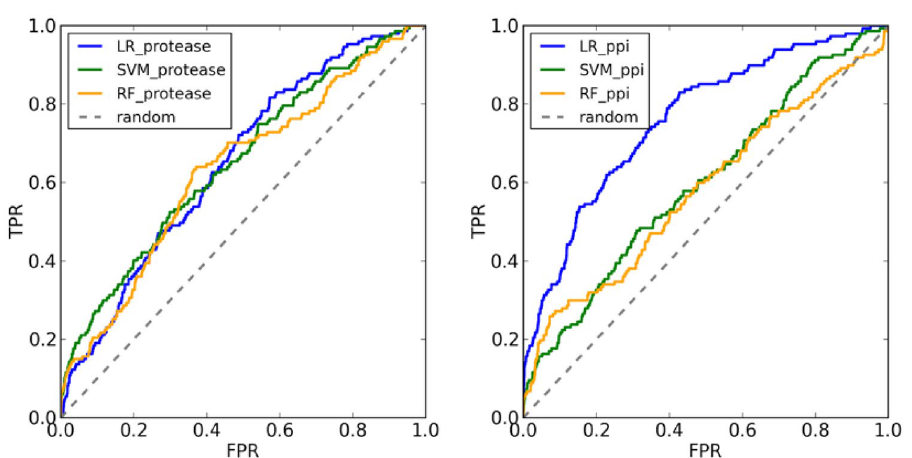
Figure 7. AUC ROC curves of the protease-specific (left) and PPI-specific (right) scoring functions trained with MLR, SMOreg and RF for the TRYB1 datasets from